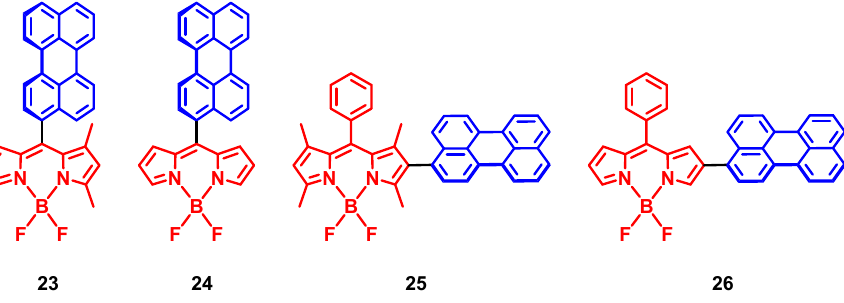
Figure 6. Molecular structures of the perynyl-Bodipy dyads showing SOCT-ISC. The PDT effect with live cells was studied with 24 (Figure 7) [18]. Compared to the 2,6-diiodoBodipy, the dark toxicity of 24 was much lower, the EC 50 values were 6.0 µ M and 78.1 µ M, respectively. Photo irradiation (500 nm; 9.6 J cm − 2 ) induced strong PDT effect (EC 50 = 75 nM). In comparison the 2,6-diiodoBodipy showed a light toxicity of EC 50 = 4 nM. Yoon et al. demonstrated that the triplet PSs based on the SOCT-ISC mechanism could also be used as PDT reagents effectively to produce 1 O 2 [49].